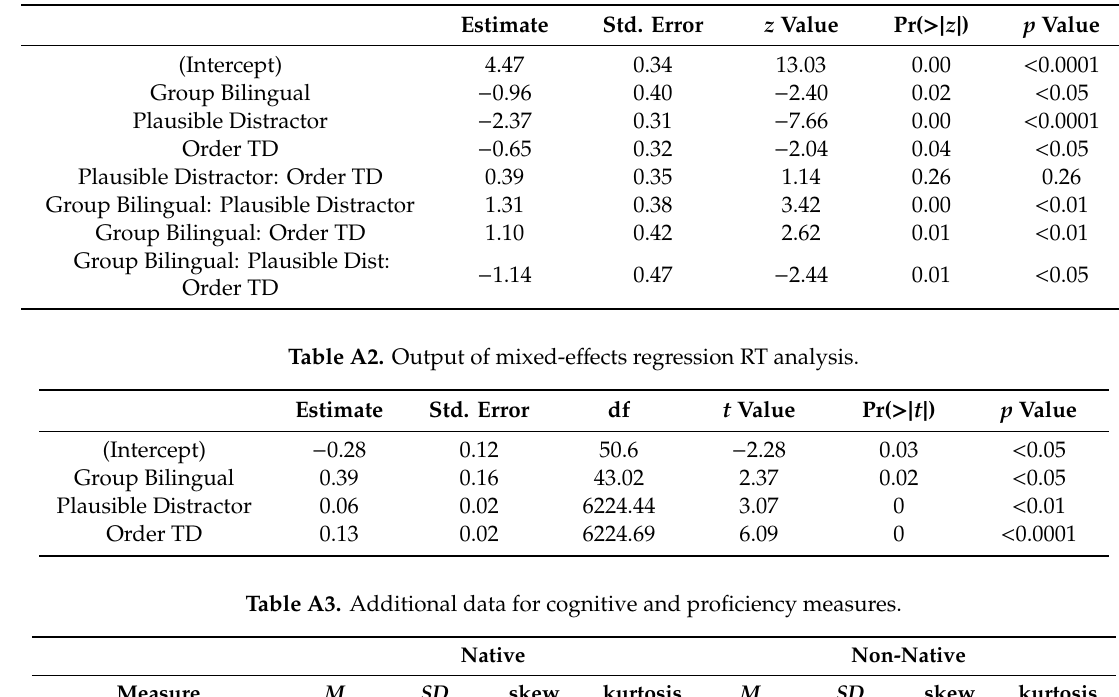
Table A1. Output of generalized linear regression accuracy analysis.